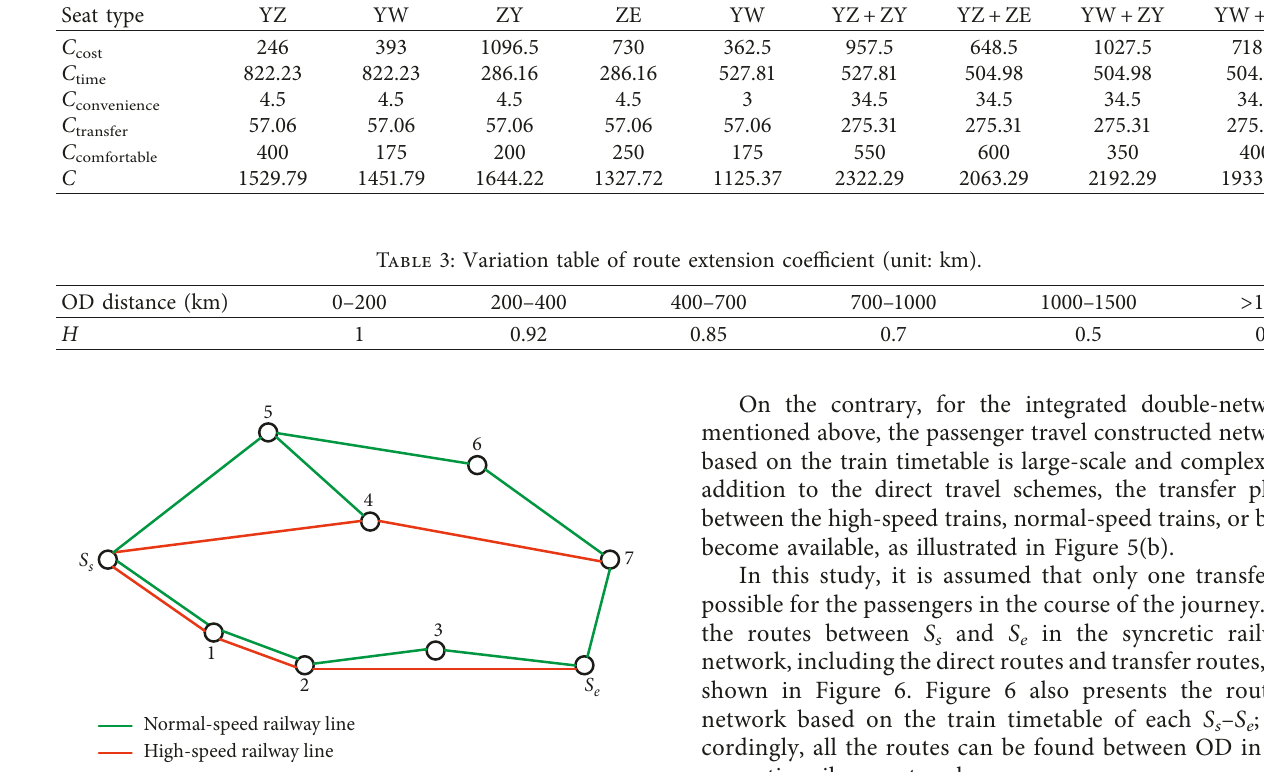
Figure 3: Simple road network of a railway under the syncretic network.